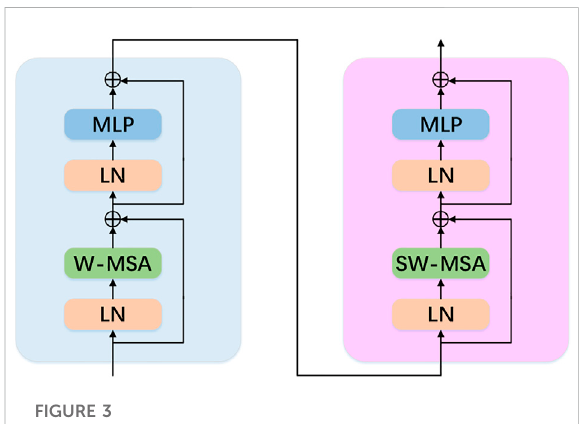
FIGURE 3 The structure of the swin transformer encoder block.